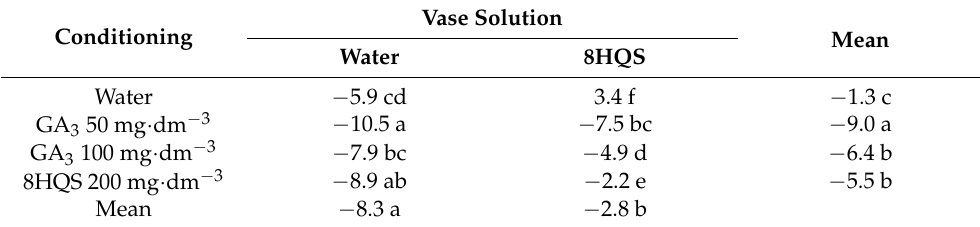
Table 2. Effect of postharvest treatment on the weight change of Viola odorata leaves (%).